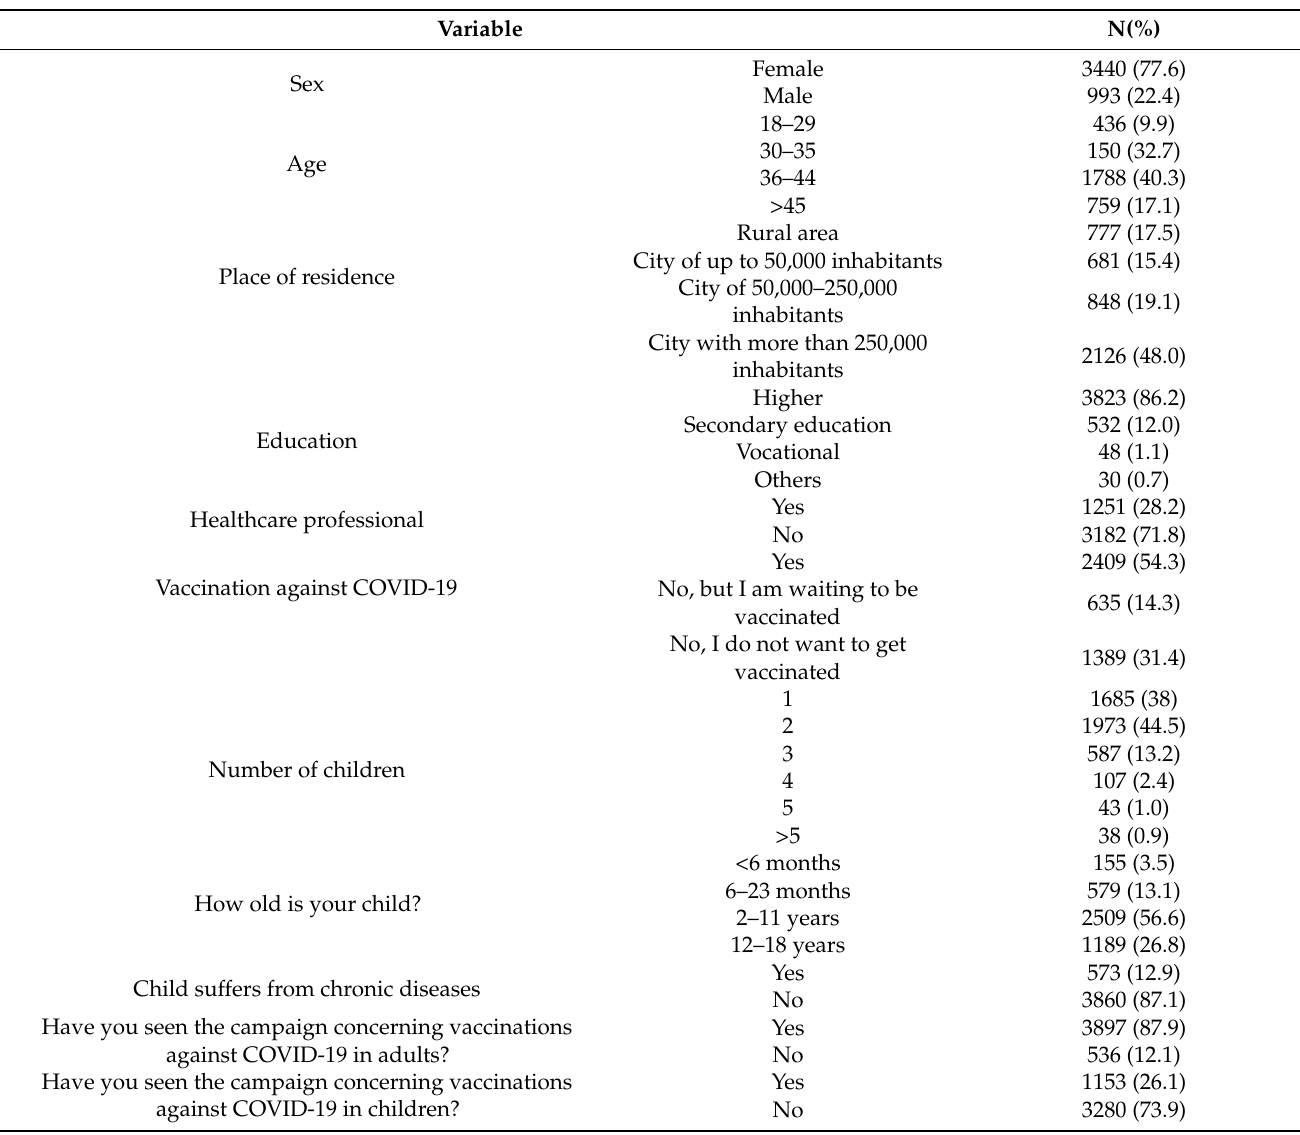
Table 1. Characteristics of the study group.